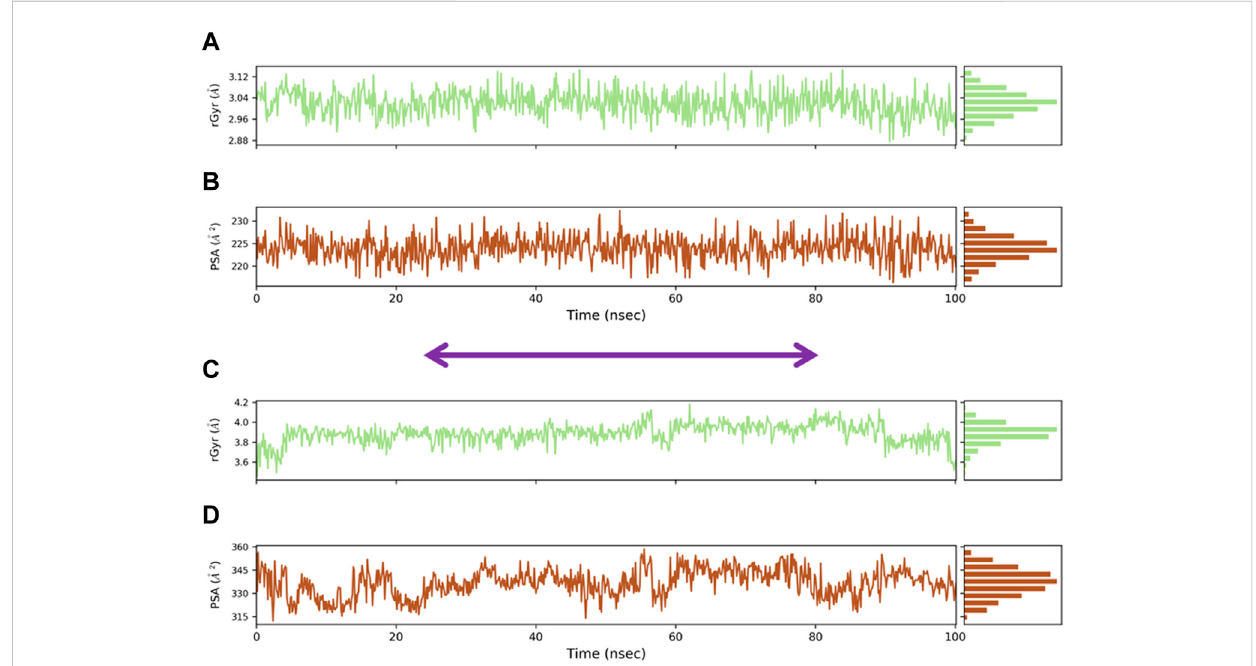
FIGURE 8 Radius of gyration (Rg) of docked complexes: (A) Radius of gyration of oleanolic acid complex, (B) PSA for oleanolic acid complex, (C) radius of gyration of kaempferol complex, and (D) PSA for kaempferol